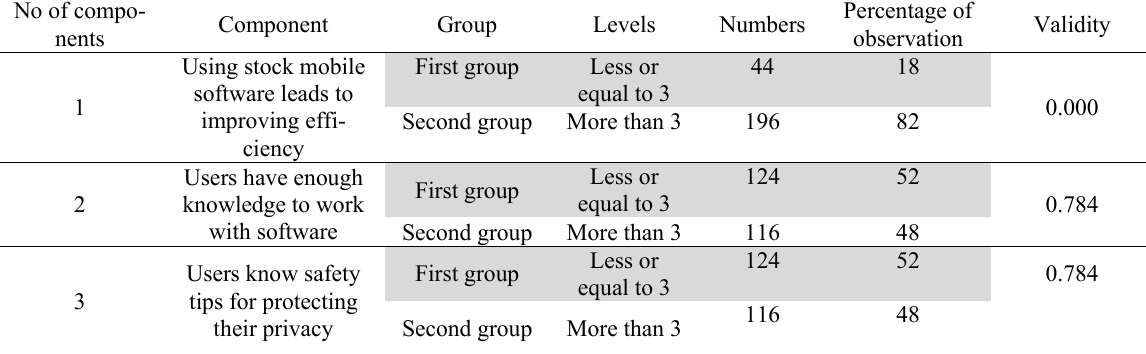
Statistical indicators for users’